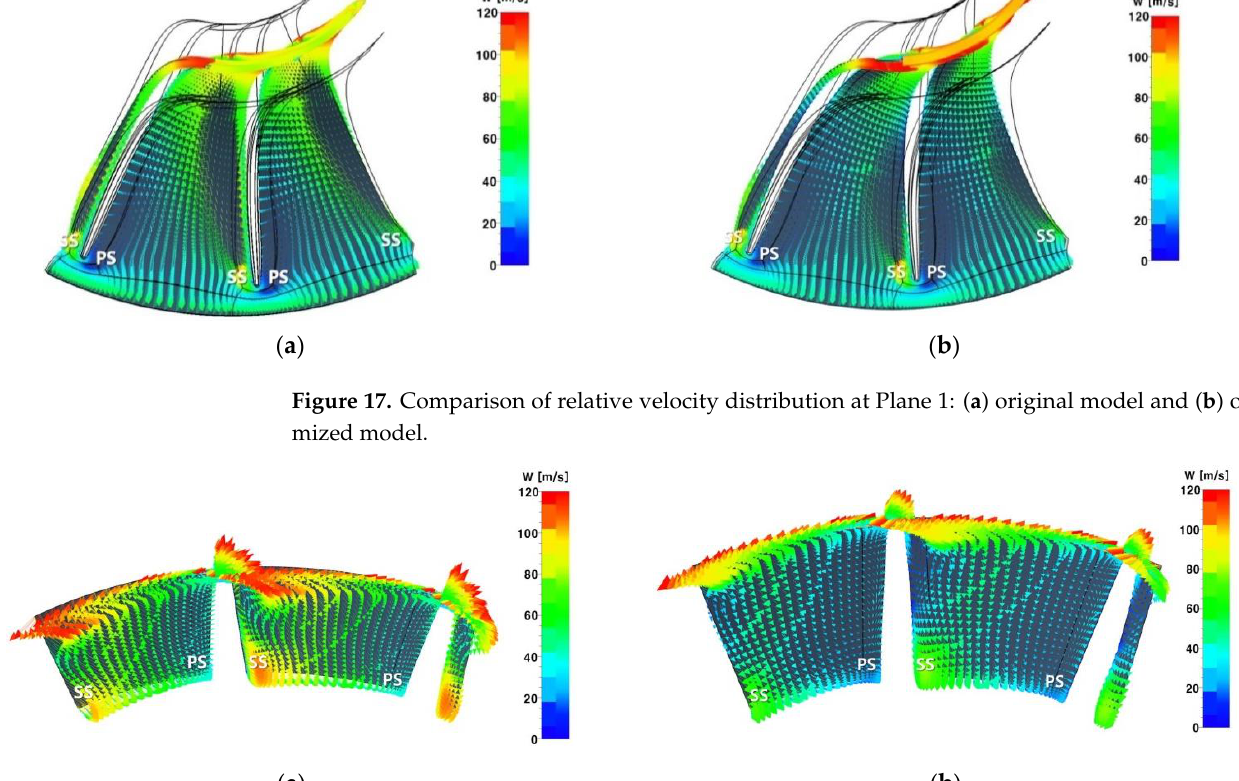
Figure 16. Comparison of entropy distribution at Plane 2: ( a ) original model and ( b ) optimized model.